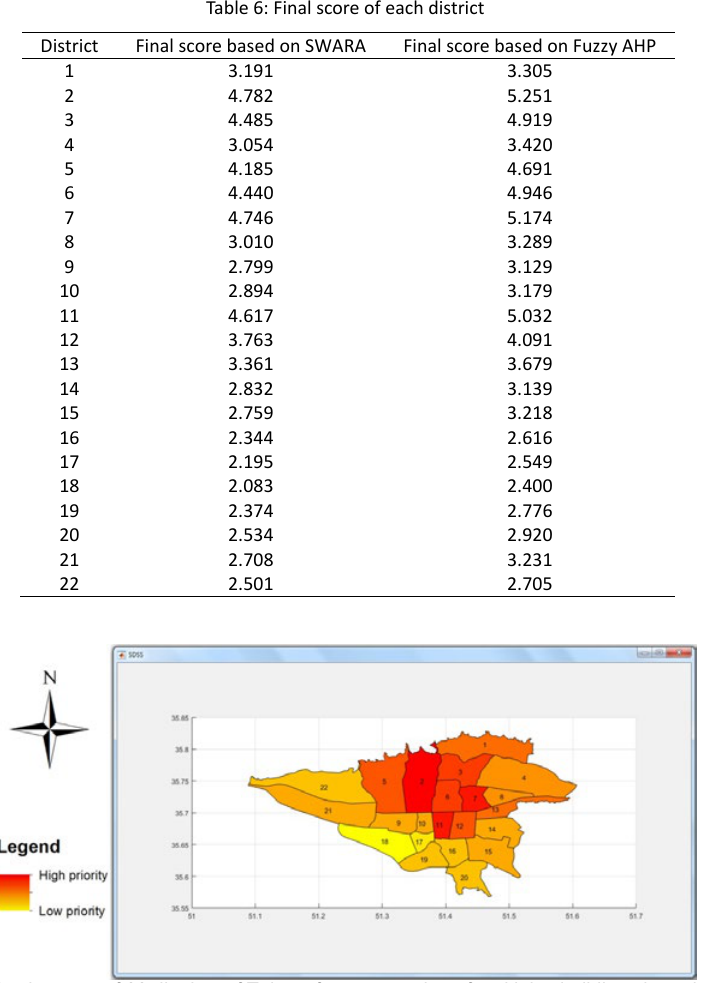
Fig. 8: Prioritization map of 22 districts of Tehran for construction of multiplex buildings based on SWARA Method